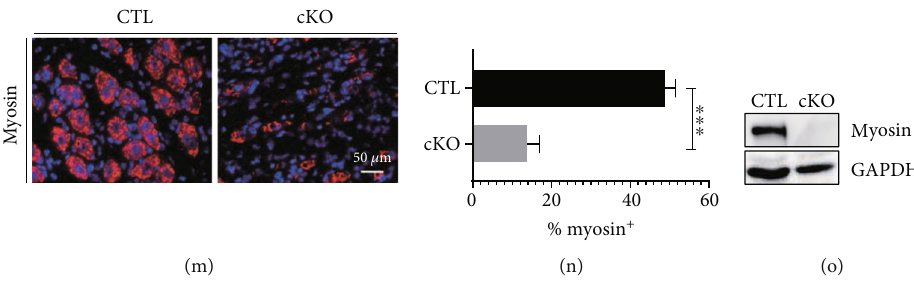
Figure 1: METTL3 is required for muscle regeneration in vivo . (a) Schematic outline of CTX injection in tamoxifen-treated CTL and cKO littermates. (b – d) Immuno fl uorescence staining and Western blot analysis of TA muscle after injection for 5 days for METTL3. (e) Hematoxylin and eosin (H&E) staining of TA muscles of METTL3 cKO mice and control littermates 2, 5, and 8 days after CTX injection. (f) Number of muscle fi bers. (g) Area of regenerating centronuclear fi bers. (h) Masson ’ s Trichrome staining of TA muscles of METTL3 cKO and control littermates. (i) Western blot analysis of Pax7, myosin, myogenin, and METTL3 protein levels in control TA muscle at day 0, day 2, day 5, and day 8. (j) Immuno fl uorescence staining of TA muscles from METTL3 cKO and control mice detected by myogenin. (k) Quanti fi cations of myogenin staining. (l) Western blot analysis of myogenin. (m) Immunohistochemical staining of myosin. (n) Quanti fi cations of myosin staining. (o) Western blot analysis of myosin. N = 10 . ∗∗∗∗ p < 0 : 0001 ; ∗∗∗ p < 0 : 001 ; ∗∗ p < 0 : 01 ; ∗ p < : 05 . CTX: cardiotoxin; TAM: tamoxifen; TA: tibialis anterior; CTL: control; cKO: METTL3 conditional